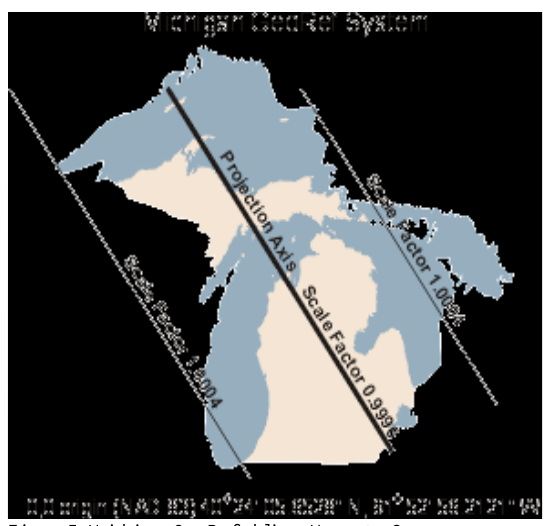
Figure 5: Michigan GeoRef oblique Mercator Source: